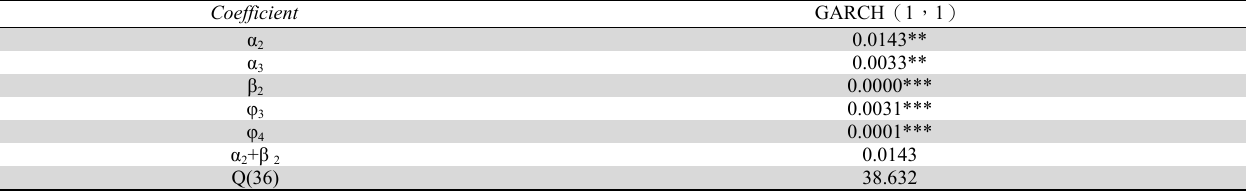
Table of GARCH (1,1) model parameters of the price volatility (PT) and explanatory variables of hot rolled coils